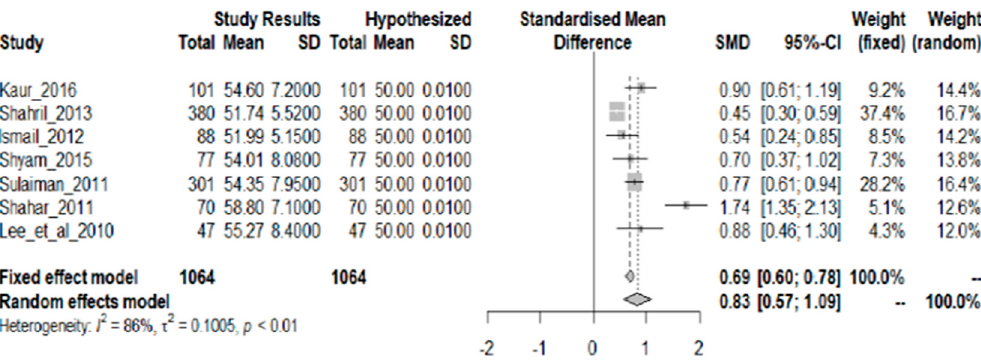
Figure 5. Meta-analysis of studies on carbohydrate intake of Malaysian Figure 5. Meta ‐ analysis of studies on carbohydrate intake of Malaysian adults.